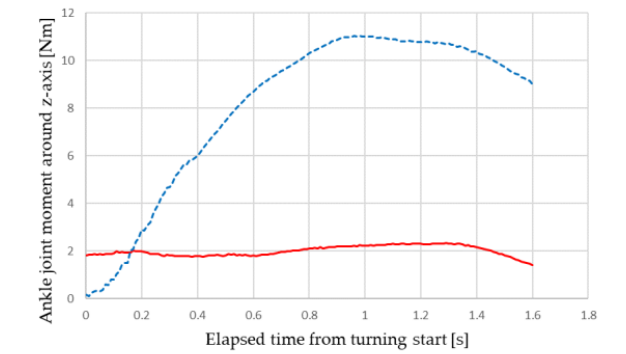
Figure 22. Ankle and knee joint moments during automatic turning.